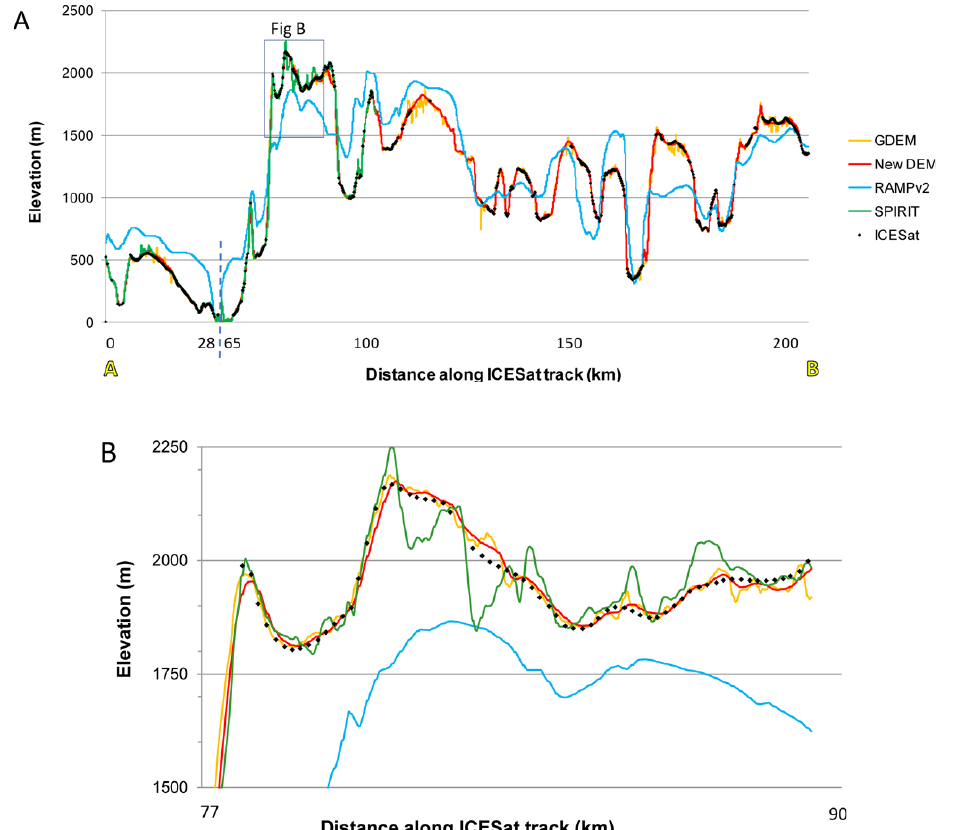
Figure 7. A profile along an ICESat track (GLA06 0144) crossing a range of topography on the Antarctic Peninsula illustrates relative di ff erences between each DEM and ICESat elevations (A) . Each DEM and the ICESat elevations are adjusted to the EGM96 Geoid. The SPIRIT DEM is based on version 2, unmasked. The inset (B) shows the di ff erences in greater detail. The profiles for 4 other ICESat tracks and a map of the ICESat track locations can be found in Supplement. See Table 1 for acronyms.